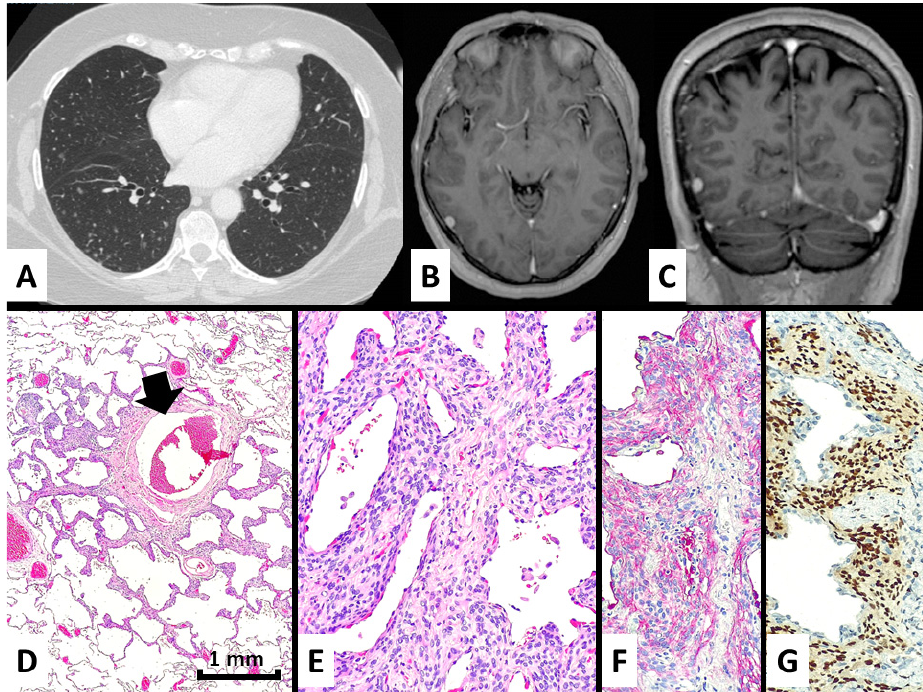
Figure 2. In case #2, the patient presented with several bilateral micronodules with ground glass periphery and some cavitation at chest CT scan ( A ) and had a previous history of non-excised meningioma in the right frontal region ( B , C ). A surgical lung biopsy demonstrated a perivenular (black arrow) and irregular proliferation of meningothelial-like cells ( D ), hematoxylin-eosin magnification × 40, growing and thickening the alveolar interstitium ( E ), hematoxylin-eosin stain magnification × 200 and expressing EMA in the cytoplasm ( F ), immunohistochemistry magnification × 200, and progesterone receptors in the nuclei ( G ), immunohistochemistry magnification × 200. All four patients were still asymptomatic at follow-up (ranging from 38 to 99 months), and no therapy was administered for DPM.